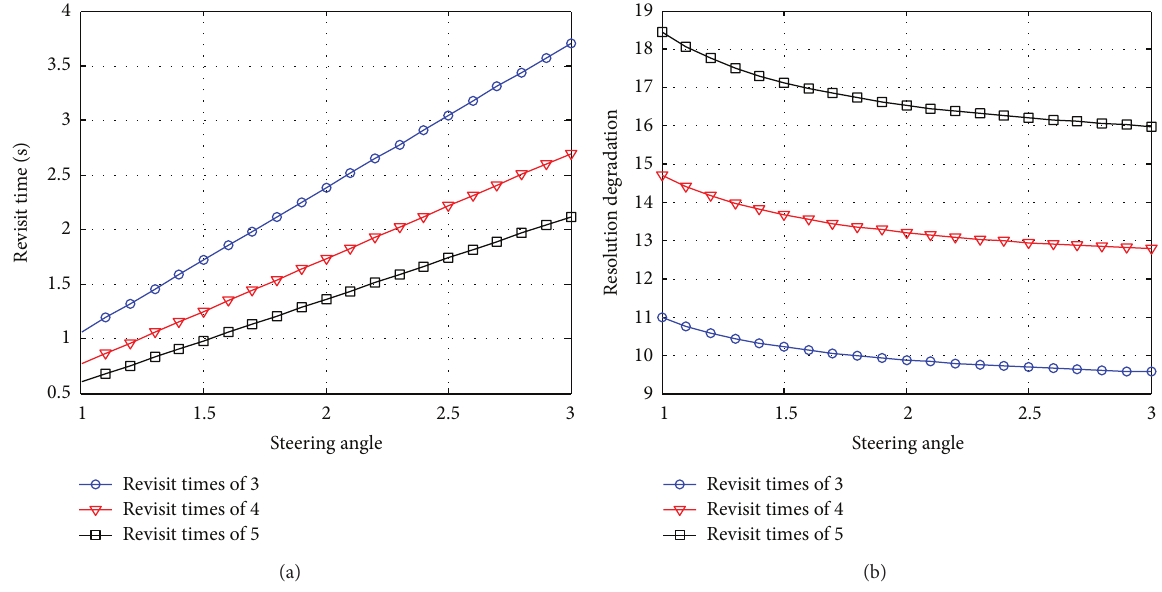
Figure 10: The revisit time (a) and the resolution degradation (b) with different revisit times.